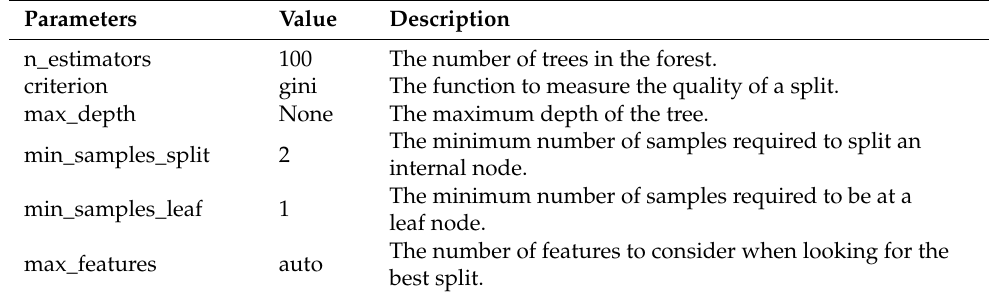
Table 13. Random Forest parameters from scikit-learn library.